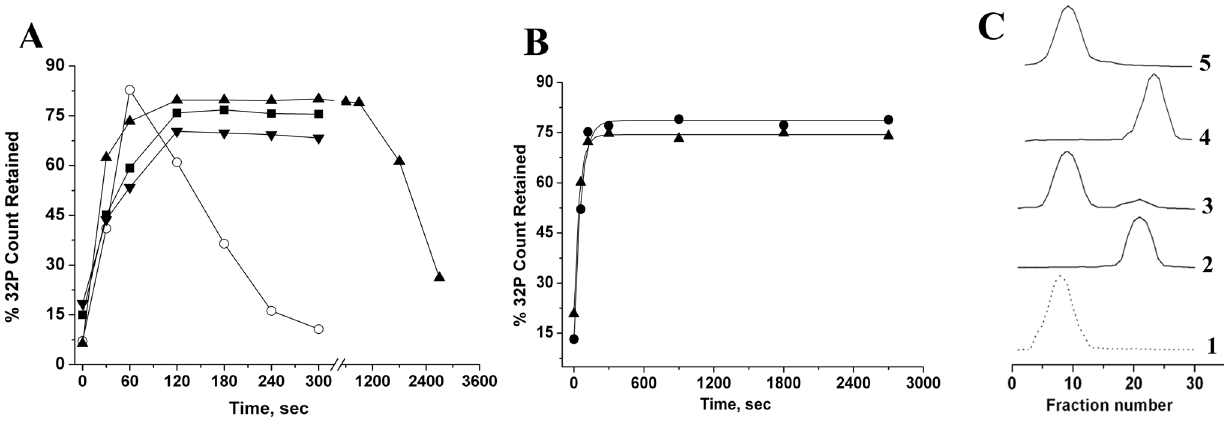
Figure 3. Interaction of BCAII and lysozyme with ribosome and its domain V RNA. Filter binding studies. Refolding of BCAII-m or reduced- denatured lysozyme was initiated in presence of radiolabeled various domain V RNA, was UV- crosslinked and filtered through nitrocellulose membrane (material and method). A) Time course of interactions of BCAII-m with radiolabeled bDV RNA (- # -), mDV RNA (- m -), bDV RNA mutants N U2585C (- . -) and delG2252 (- & -) are shown here. Experiments were repeated thrice and their average values were taken for final data plotting. B) -) and mDV RNA (- m -) are shown. Size exclusion Time course of interactions of reduced-denatured lysozyme and radiolabeled bDV RNA (- chromatography. Refolding of FITC labeled BCAII-m or reduced-denatured lysozyme was initiated in presence of 70S ribosome, was UV-crosslinked at 30 second of refolding, and the mix was loaded on Sephacryl S-300 column. The elution of the protein and the ribosome was monitored by fluorescence at 518 nm and absorbance at 260 nm. C) Detection of 70S- BCAII complex. The elution profiles of BCAII-m in presence of ribosome at 30 seconds of refolding (3), reduced denatured lysozyme in presence of ribosome at 30 seconds of refolding (5) are shown. The elution profiles of ribosome (1), native BCAII (2) and native lysozyme (4) are also shown for